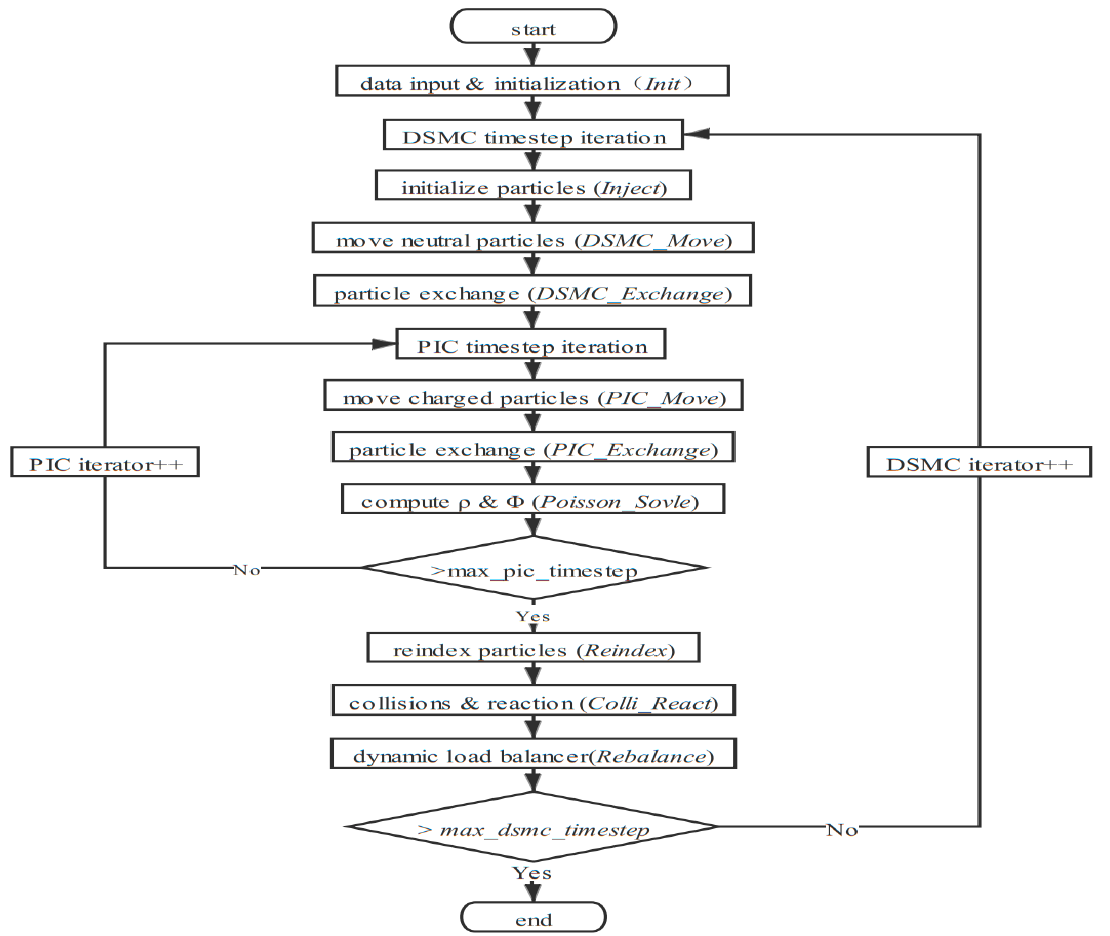
Figure 2. DSMC/PIC flowchart for the parallel algorithm [30].